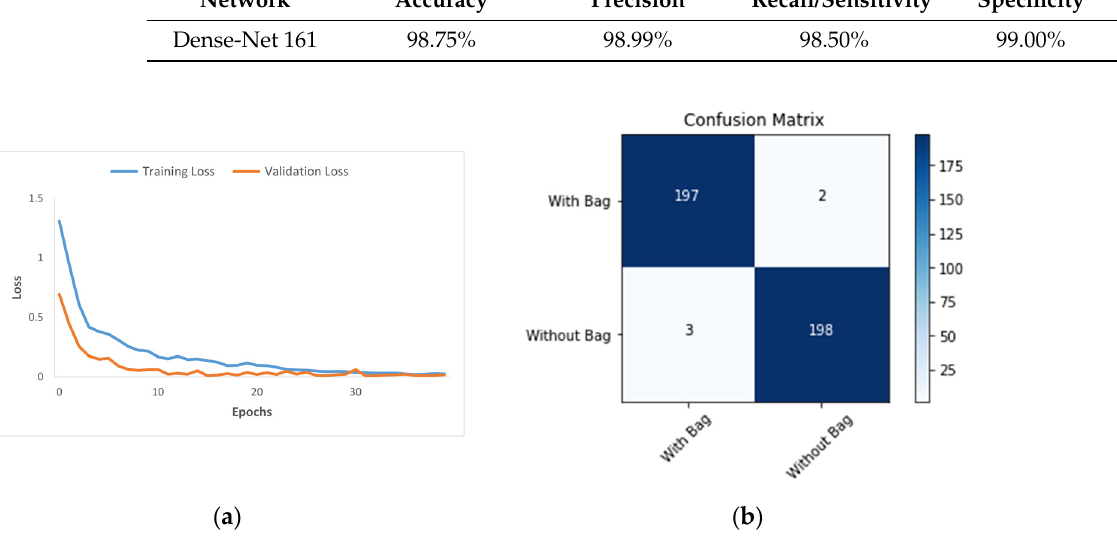
Figure 9. The loss curve and confusion matrix of the second experiment on INRIA, ILIDS, and MSMT17 datasets: ( a ) The loss curve, ( b ) the confusion matrix.